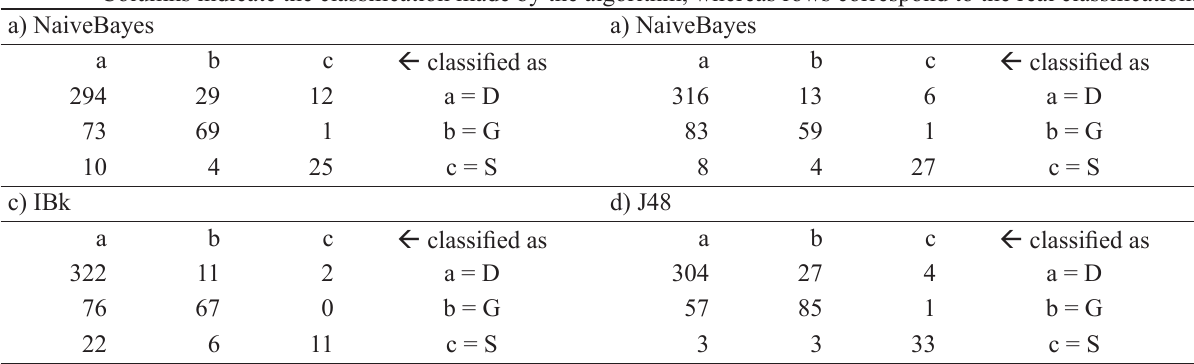
Table 2. Confusion matrices for a) NaiveBayes with supervised discretisation; b) SMO with Puk kernel; c) IBk with 9 KNN; d) J48 with a confidence factor of 0.06. Abbreviations are: D, dolomite; G, gypsum; S, serpentine. Columns indicate the classification made by the algorithm, whereas rows correspond to the real classification.